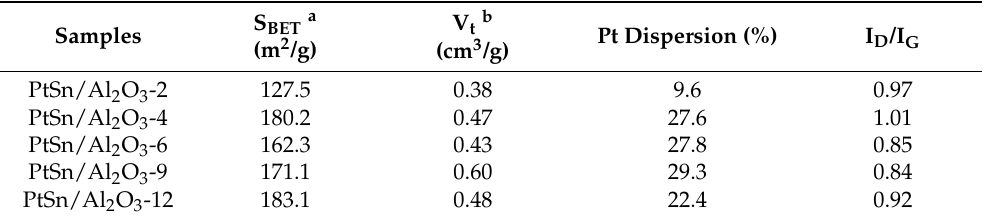
Table 1. Textural properties and Pt dispersions of PtSn/Al 2 O 3 catalysts, I D /I G by Raman characteri- zation of the spent catalysts.